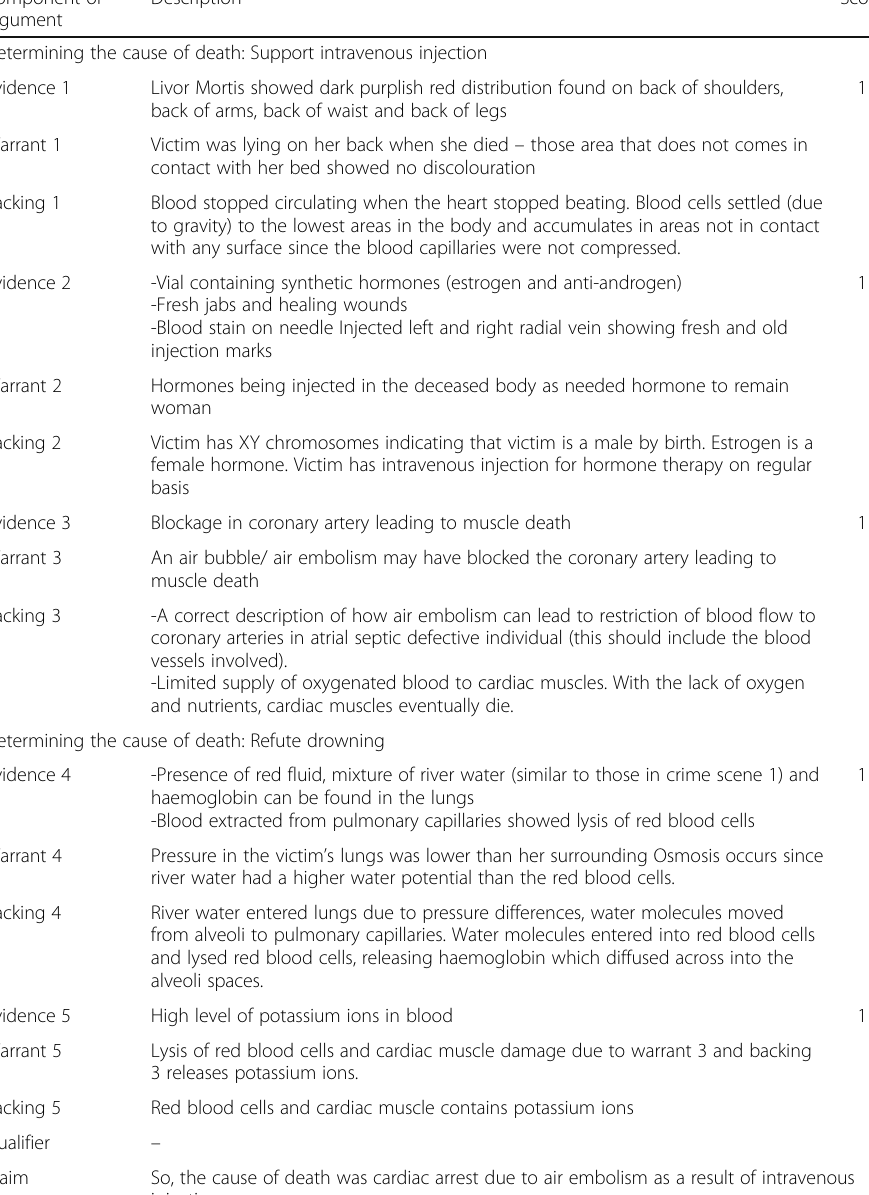
Table 3 Scoring scheme for strength of argument Component of Description Score argument Determining the cause of death: Support intravenous injection Evidence